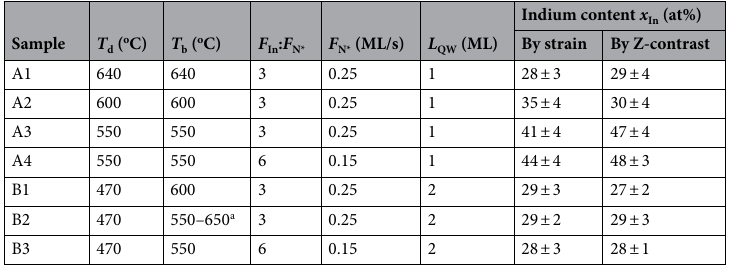
Table 1. List of samples with QW and barrier deposition temperatures T d and T b , respectively, flux ratios ( F